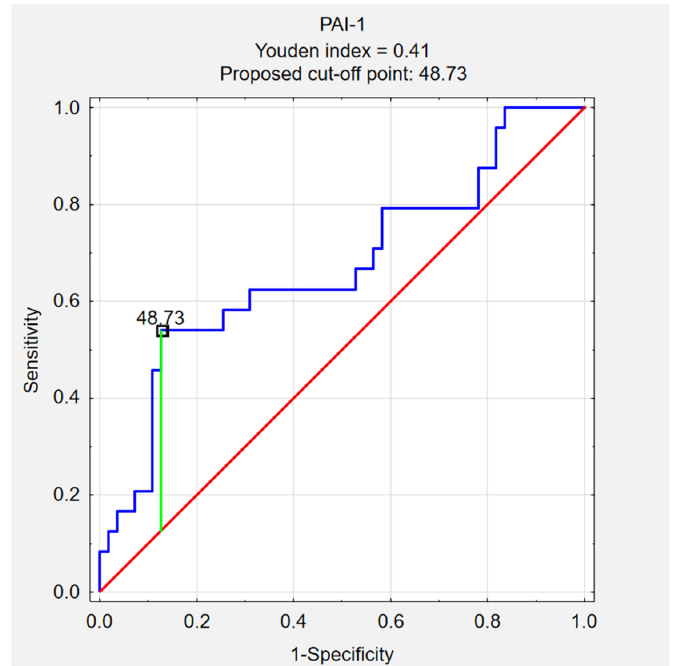
Figure 3. ROC curve for PAI-1.